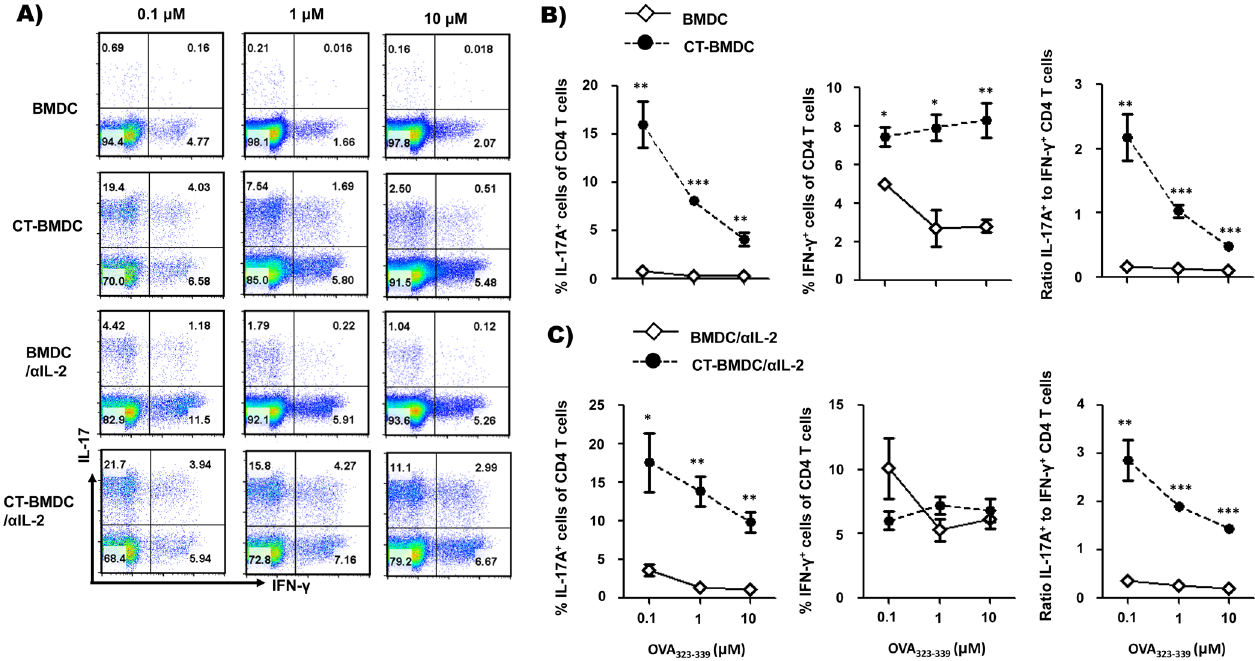
Fig 4. Depletion of IL-2 recovers Th17 cell differentiation. Assessment of OT-II CD4 + T cell differentiation by untreated or CT-treated BMDCs pulsed with the indicated concentration of OVA 323-339 peptide in the absence (A and B) or presence of neutralizing IL-2 antibody (10 μ g/ml) (A and C). * p < 0.05, ** p < 0.01, *** p < 0.001 (Student ’ s t -test). Dot plots and data are from one experiment representative of at least two independent experiments with similar results and average ± SEM of triplicate